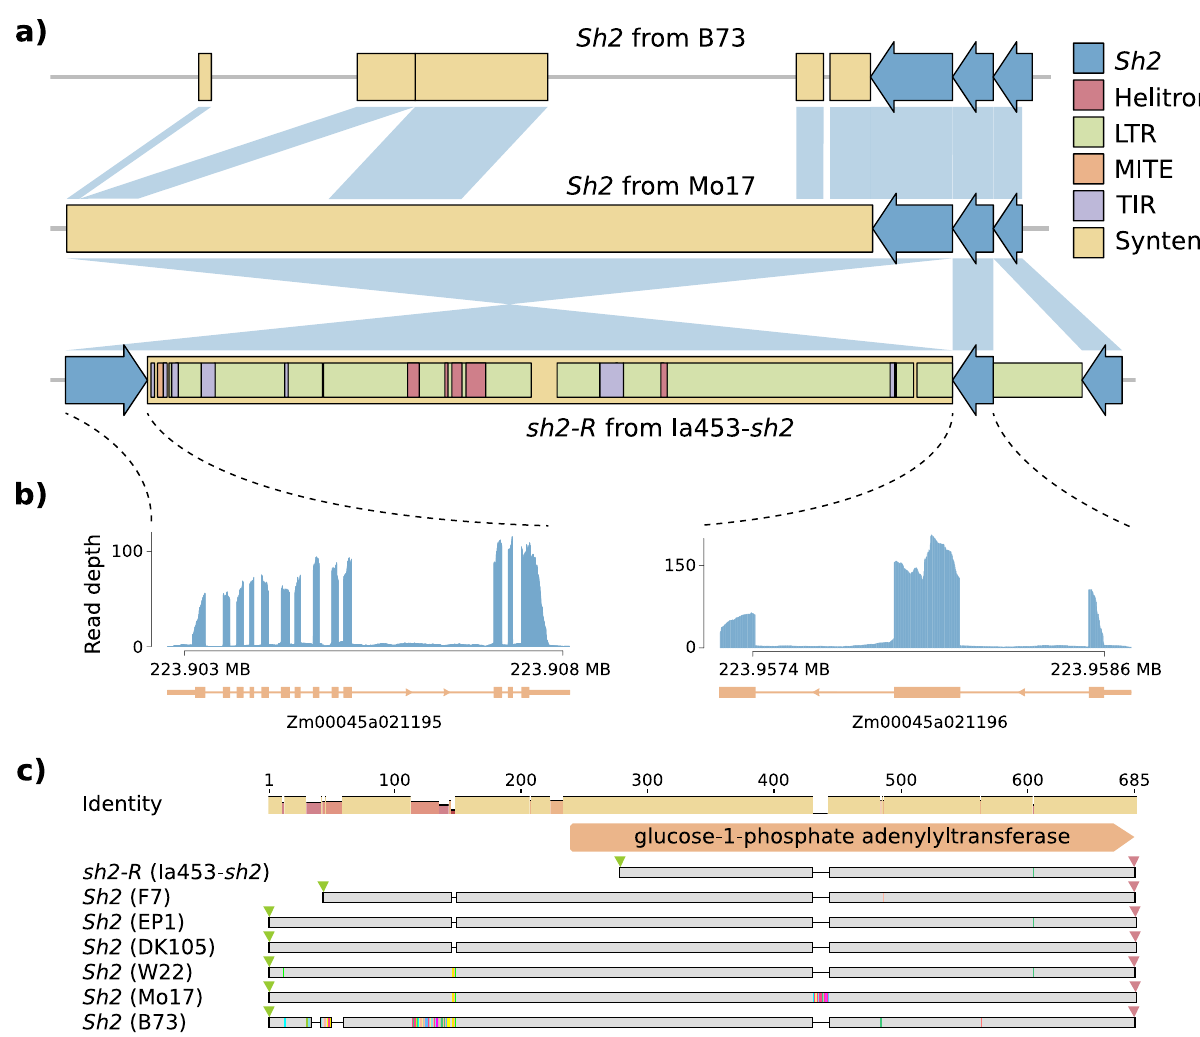
Fig. 2 Structural variation of the sh2 - R allele. a Scheme of the structural variations between Sh2 in B73 and Sh2 in Mo17 (the top pairwise comparison) as well as Sh2 in Mo17 and sh2-R in Ia453- sh2 (the bottom pairwise comparison). The Sh2 in B73 and Mo17 is drawn the same size as the sh2 -R allele in Ia453- sh2 (blue arrows). Features within each allele are drawn to scale. The syntenic regions were drawn as yellow boxes and connected using blue wedges. The annonated TE elements are only shown in Ia453- sh2 for simplicity. Two insertion sequences in the sh2 - R allele contain a variety of predicted TE elements. b Two predicted gene models annotated in the sh2-R loci and their expression pro fi le represented as the number of reads per Gb of total RNA-seq aligned reads. c Comparison of the predicted amino acid sequences of sh2-R (Zm00045a021195) from Ia453- sh2 with Sh2 from six fi eld corn lines, using the Geneious multiple sequence alignment. Conserved amino acids are marked in gray, gaps are indicated as lines and differences are highlighted with different colors. The identity panel displays the identity across all amino acid sequences for every position. Small green and red triangles are indicating start and stop codons,